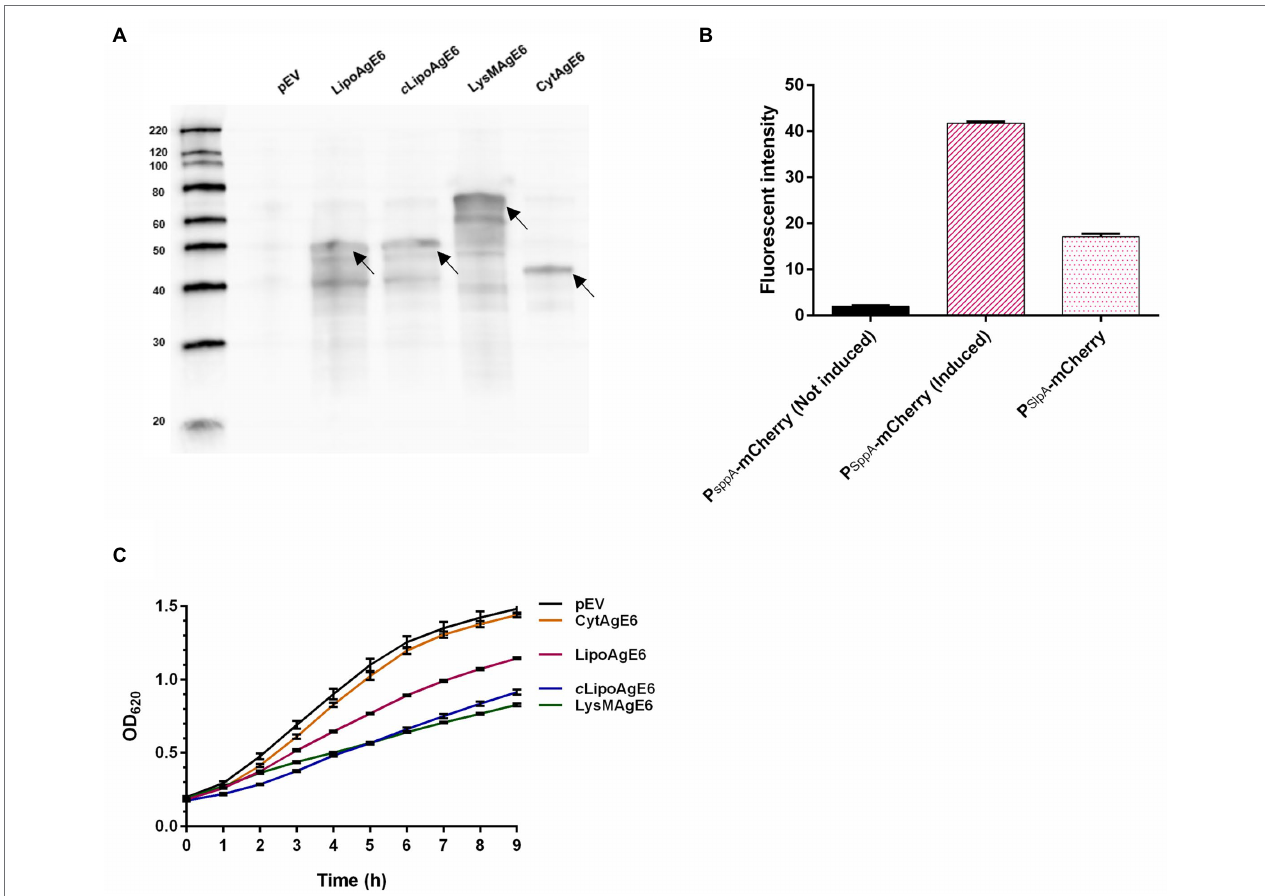
FIGURE 3 | Characterization of the vaccine candidates. (A) Western blot analysis of crude protein extracts of the Ag85B-ESAT6-DC (AgE6) expression strains. The volume of loaded samples was adjusted based on the OD 600 upon harvesting, meaning that approximately equal amount of protein was loaded. Lanes: left lane, molecular marker (masses indicated in kDa); pEV, negative control; LipoAgE6 (50 kDa), c LipoAgE6 (50 kDa; constitutive promoter), LysMAgE6 (64 kDa), and CytAgE6 (44 kDa). The arrows point to the bands at the correct sizes. (B) Analysis of promoter strength using the fluorescent protein mCherry as a reporter gene. The fluorescence was measured 3 h after induction or 5 h of growth for P sppA -mCherry and P slpA -mCherry, respectively. P sppA is the inducible promoter used in most constructs and P slpA is the constitutive promoter used in c LipoAgE6. (C) Growth of the recombinant strains. The cultures were prepared as described in materials and methods. Induced cultures were transferred to a 96-well plate in eight technical replicates after induction (time = 0). The OD 620 was measured continuously, every 15 min, for 9 h. Every fourth datapoint is shown as the mean of eight technical replicates ± standard deviation to emphasize that the growth curve was measured continuously. The data presented in A , B , and C are from one representative experiment, but all analyses have been performed three times, showing similar